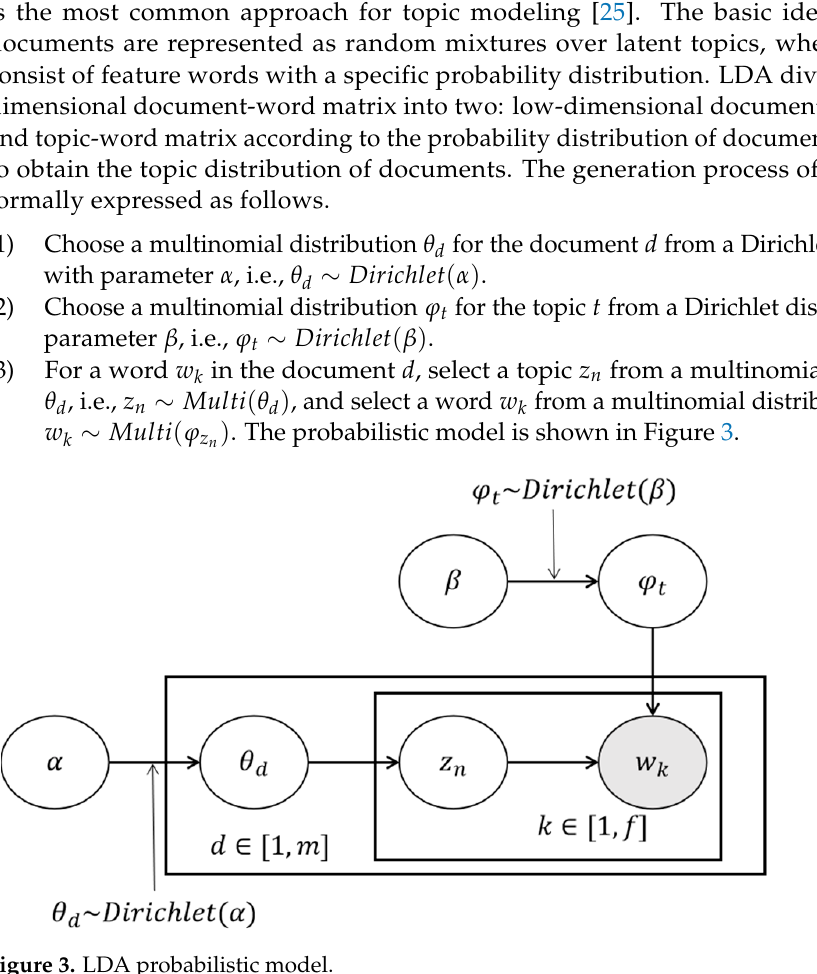
Figure 3. LDA probabilistic model.